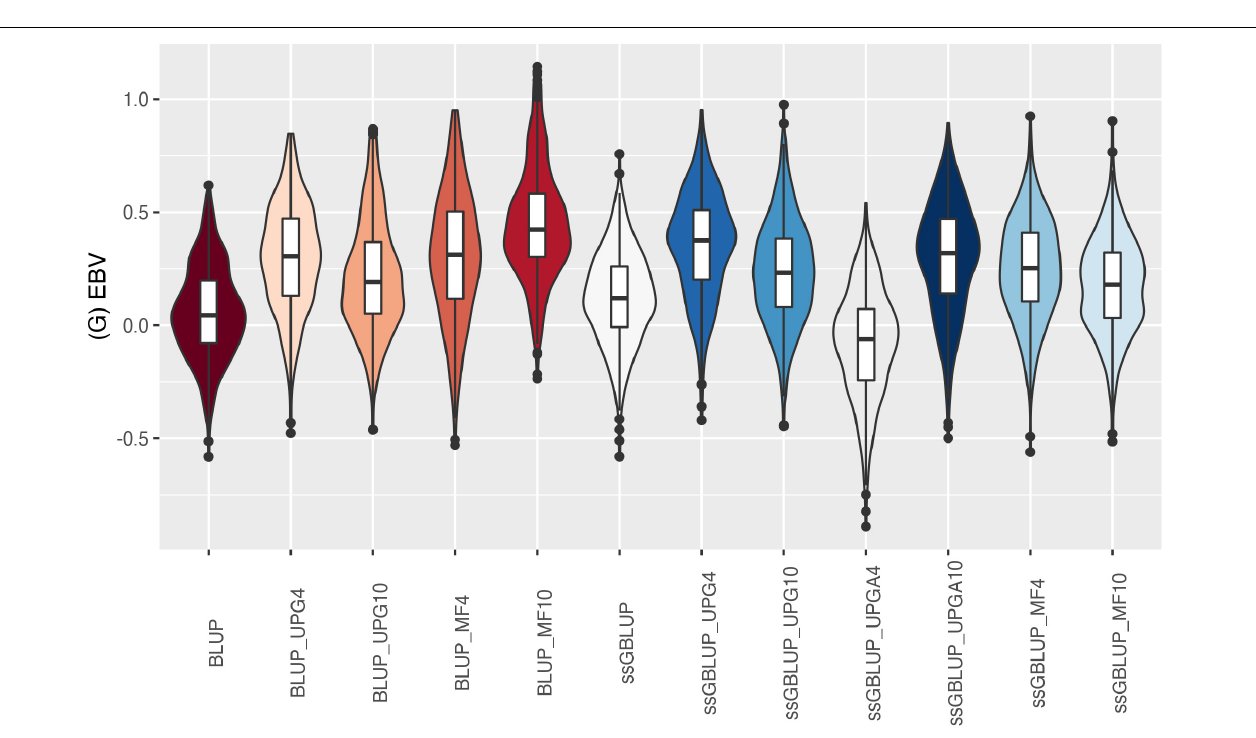
FIGURE 12 | (G)EBVs for validation animals for birth weight direct estimated using various models with and without genetic groups. (G)EBVs, (genomic) estimated breeding